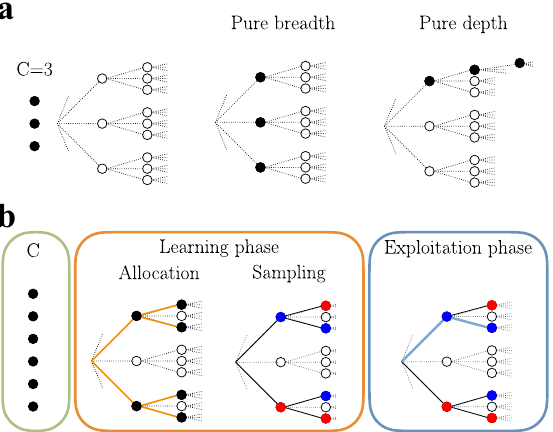
Figure 1. Planning decisions in large decision trees with finite sampling capacity. ( a ) Breadth-depth dilemma in an infinitely large decision tree. Nodes correspond to states, and edges correspond to possible actions resulting in deterministic transitions from the parent node to the selected children node. Sampling a node results in learning whether the node would promise high or low expected reward when actually visiting it. The agent can allocate finite sampling capacity C ( C = 3 in the example) to gain information about the structure of expected rewards. Samples can be allocated broadly in the first levels (breadth search, middle panel), deeply in few branches (depth search, right panel), or using any intermediate policy. ( b ) The agent solves the planning problem in two phases: in the learning phase (orange panel), samples are allocated in one shot to learn about the magnitudes of the expected rewards of the nodes, and in the exploitation phase (blue panel) the learned expected rewards are used to select the optimal path (blue path). In the example, the 6 samples are allocated (allocation; closed circles), after which the agent learns about the expected rewards from the sampled nodes (sampling; blue, positive expected reward R + learnt; red, negative expected reward R − learnt). For the case p = 1 2 , illustrated in the figure, the expected rewards take values R + = + 1 and R − = − 1 with equal probability, while the expected rewards for unsampled nodes remain 0, and are not indicated in the figure. After sampling, the agent can select the optimal sequence of actions, the one with the highest expected cumulative reward, which in this case corresponds to the blue path, with expected cumulative reward equal to 1 + 1 = 2